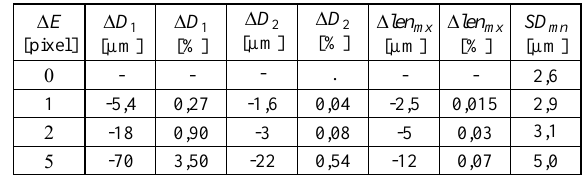
Figure 5: Rms epipolar line error and corrected rms